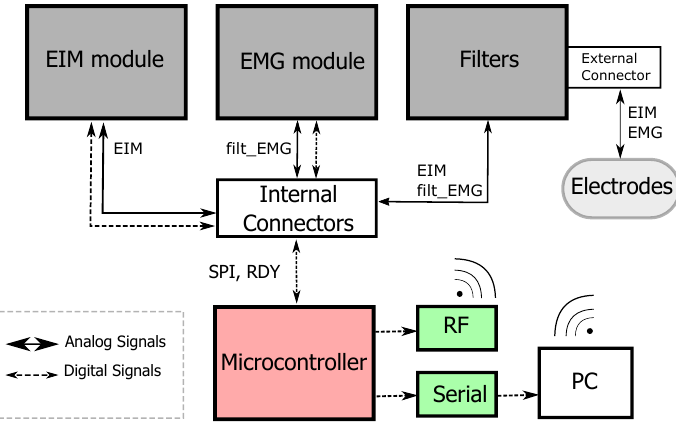
Figure 4. Overall structure of the EMG-EIM system.